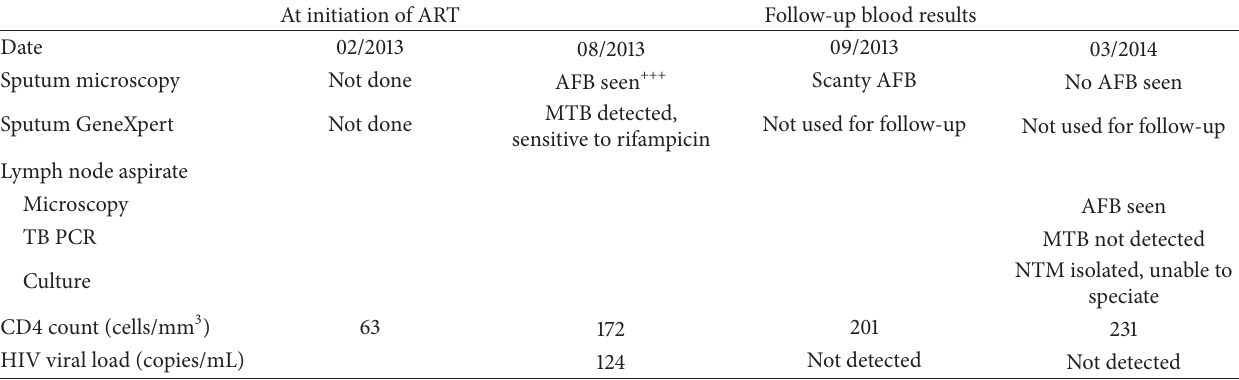
Table 2: Showing ART monitoring blood results and TB microbiology results.